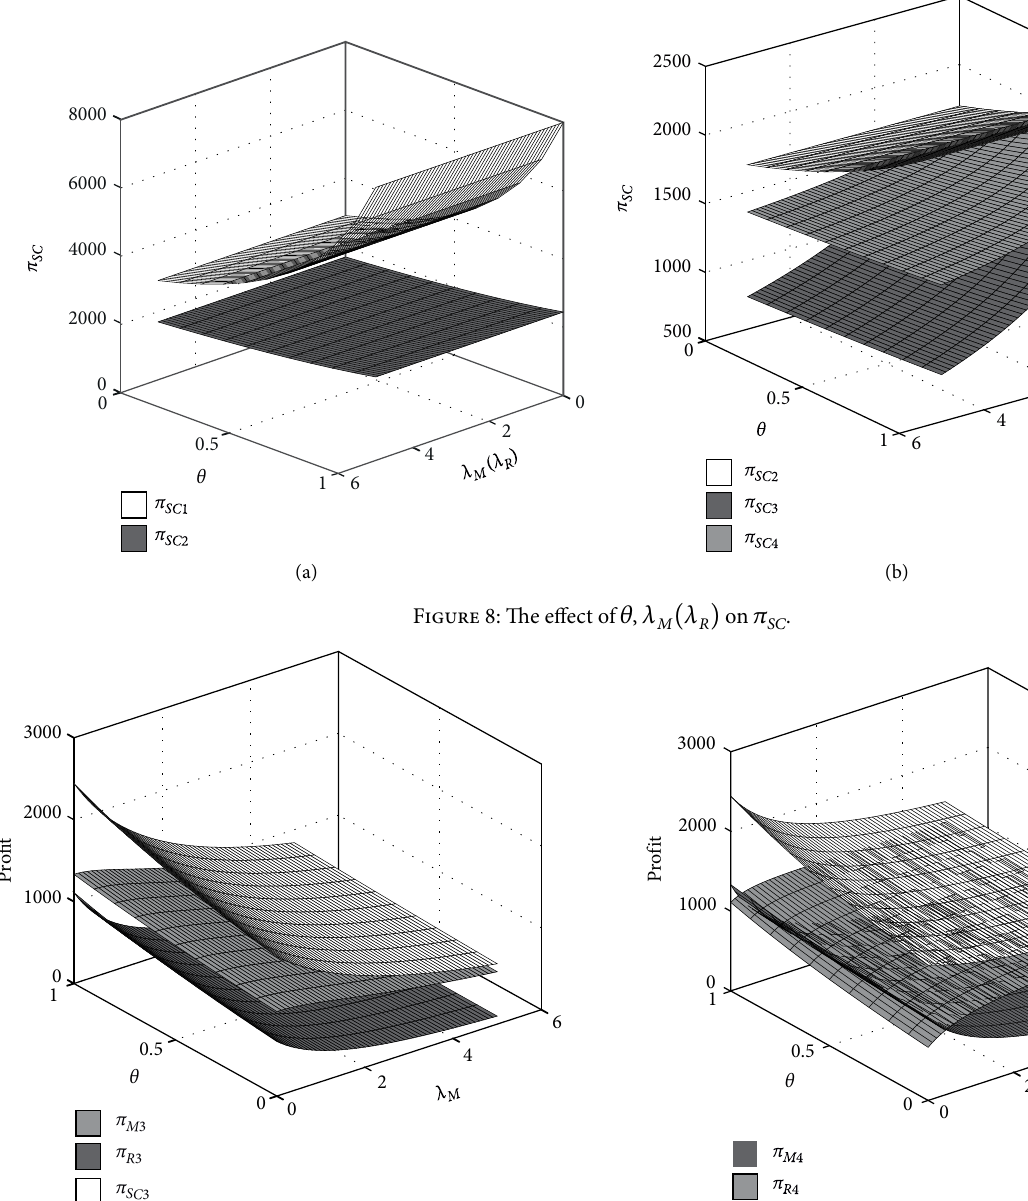
Figure 9: The effects of 𝜃 , 𝜆